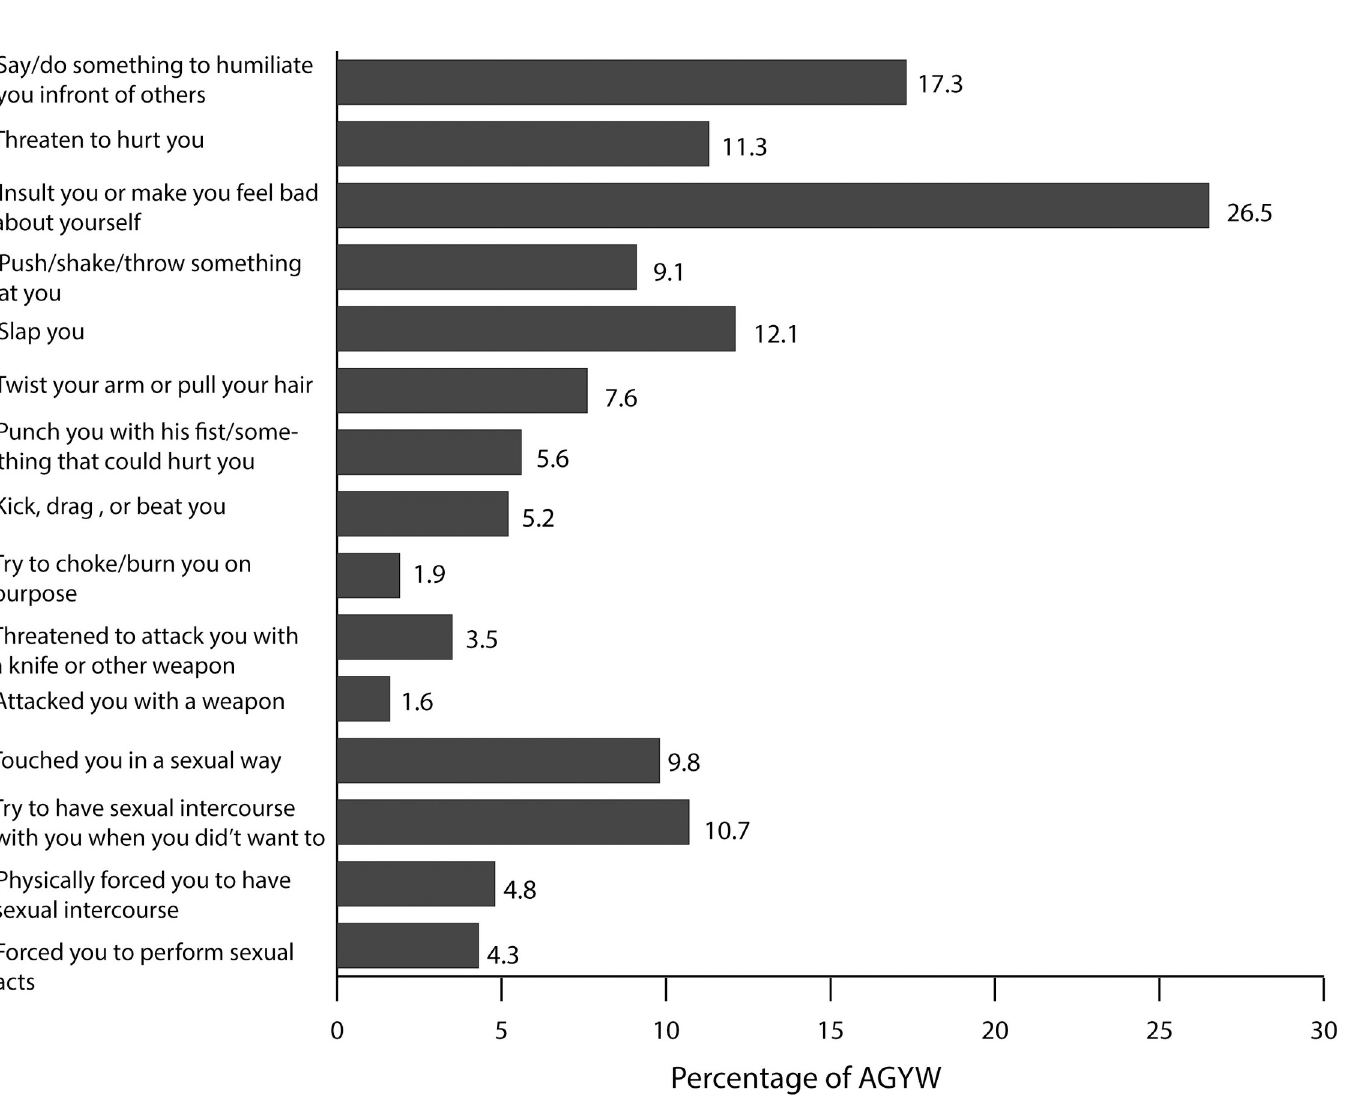
Fig 1. DREAMS survey data: Percent of AGYW reporting each of the 15 acts of